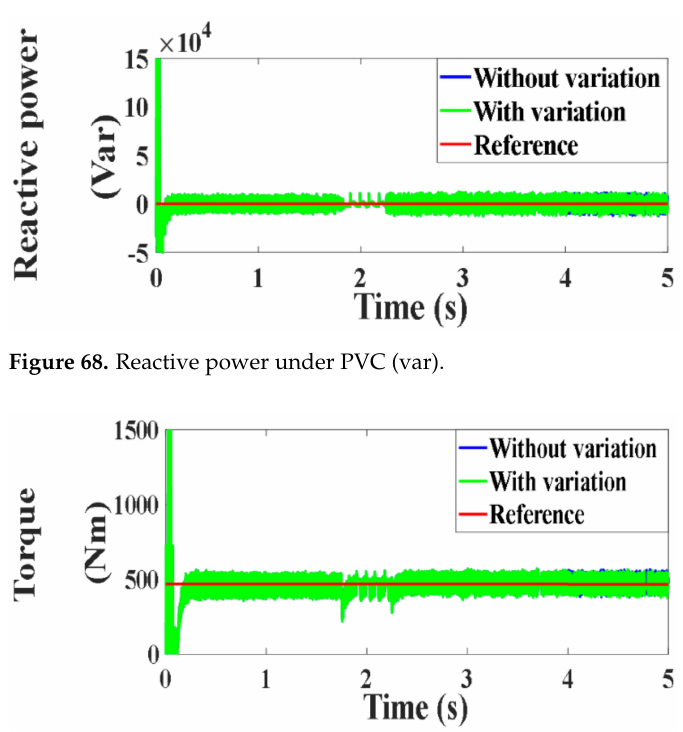
Figure 67. Active power under PVC (Watt).